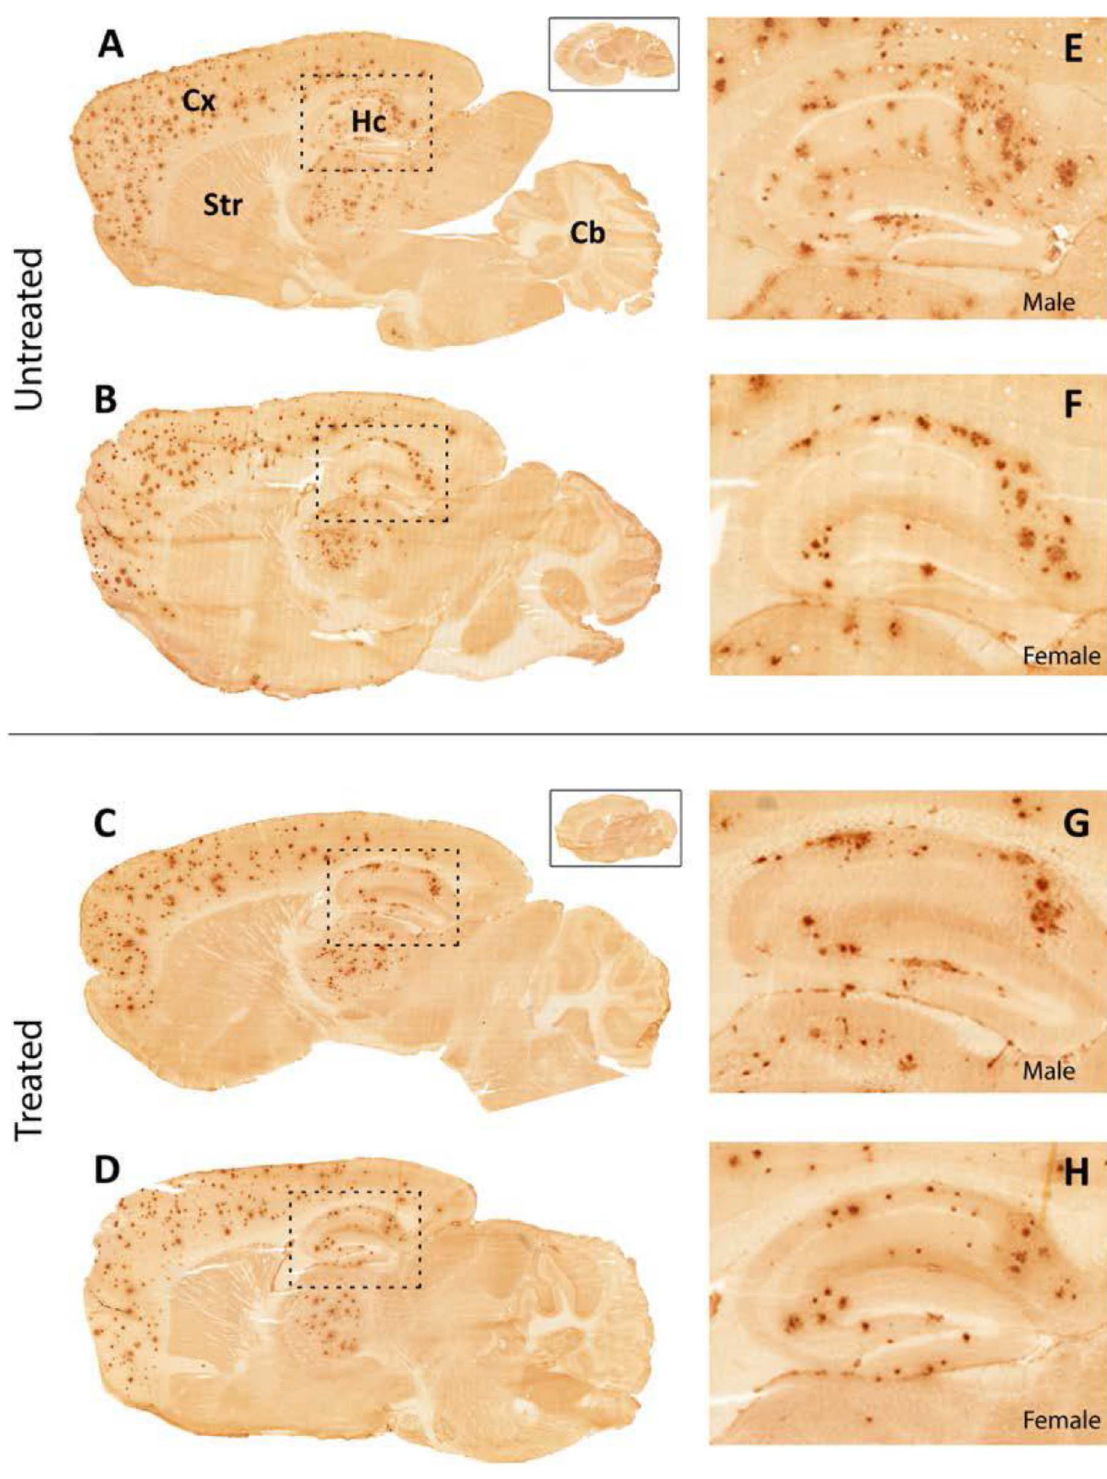
Figure 3. Immunohistochemistry for A b -deposits in the male and female mouse brain. Immunohistochemistry for amyloid (A b x-40) in the right hemisphere of male and female mouse brain. A b -deposits are found throughout the cerebral cortex (Cx) and hippocampus (Hc) in all animals regardless of treatment. Enlarged images E–H show morphological details in the hippocampus. Insets show sections from wild-type animals of corresponding genders demonstrating that background staining was low.